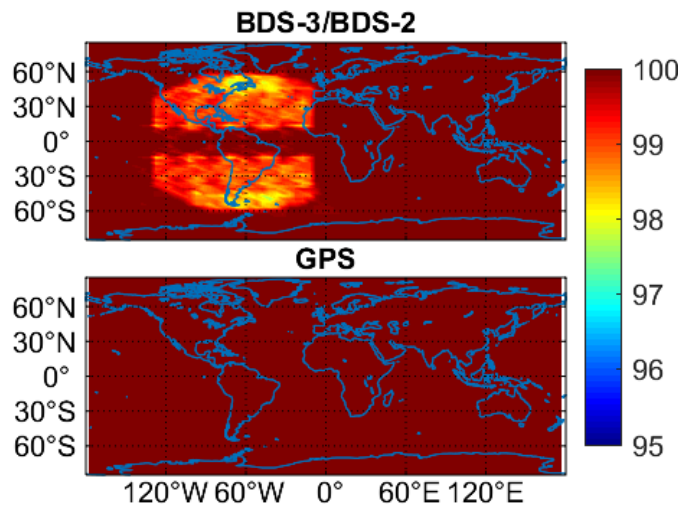
Figure 4. PNT service rate for BDS-3 / BDS-2 and GPS on DOY 140–146 of 2020.